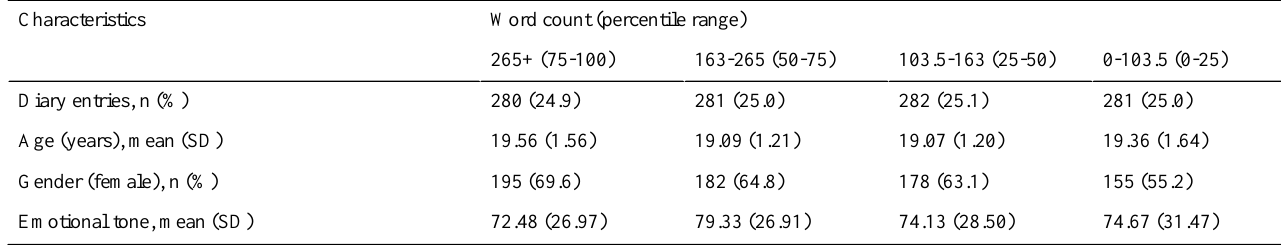
Table 4. Key sample and diary characteristics by diary-compliance subsamples.